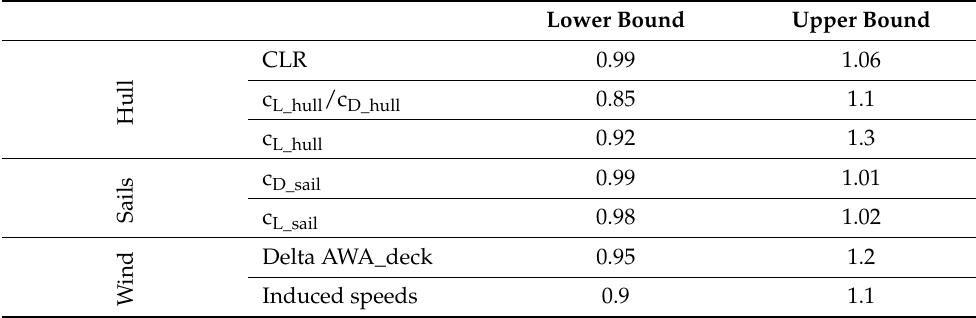
Table 5. Upper and lower bounds for the variation